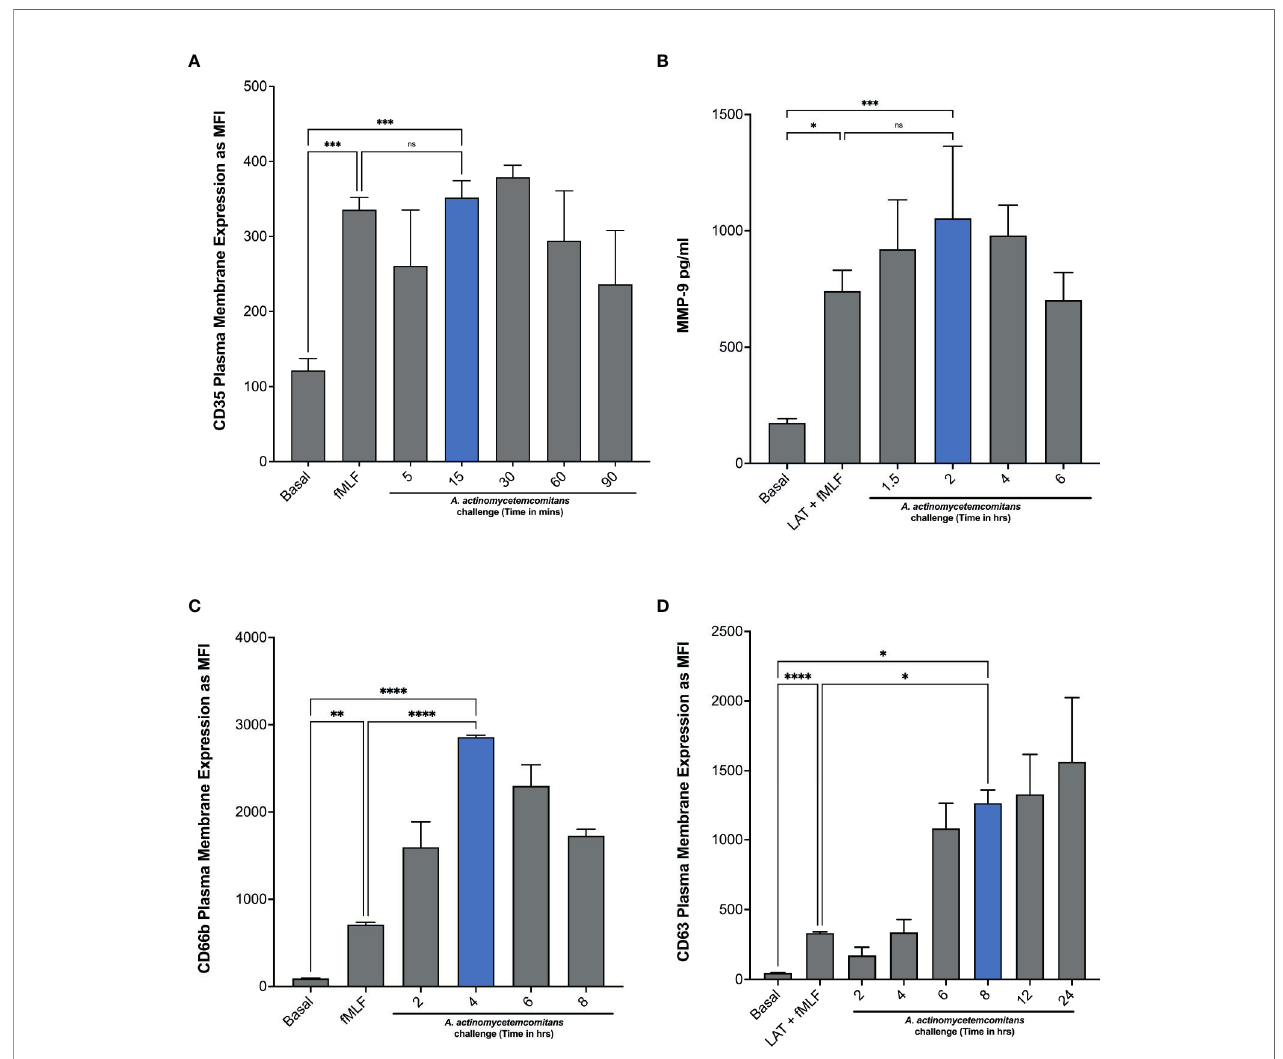
FIGURE 3 | A . actinomycetemcomitans induces exocytosis of all four neutrophil granule subtypes. Induction of neutrophil granule exocytosis was determined by challenging human neutrophils with A . actinomycetemcomitans (MOI 50) for 1.5 h, 6 h, 8 h, and 24 h Increased plasma membrane expression of CD35 (A) , CD66b (C) , and CD63 (D) was measured to de fi ne secretory vesicles, speci fi c granules, and azurophil granule exocytosis, respectively, by fl ow cytometry. Basal levels and latrunculin (Lat) + fMLF were used as negative and positive control. Granule markers are plotted as the mean channel fl orescence intensity (MFI) ± SEM of